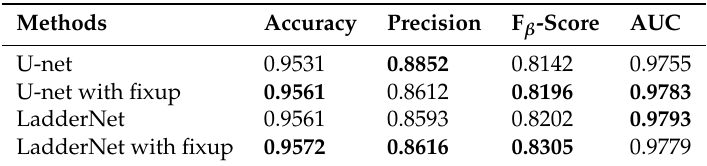
Table 1. Results on DRIVE data set.